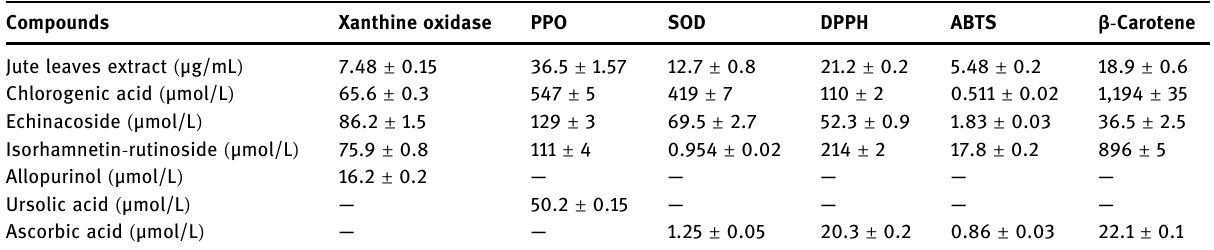
Table 3: IC 50 values for enzyme inhibitions and EC 50 values for antioxidant activities of jute leaves extract and three inhibitors Compounds